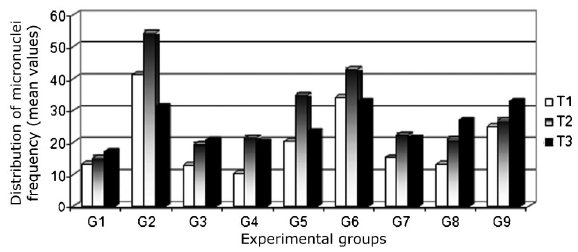
Figure 1. Distribution of the micronuclei frequency (means) in peripheral blood of mice during the 72 h of experimentation. G1: phosphate-buffered saline (PBS; negative control); G2: cyclophos- phamide (CPA; positive control); G3 to G6: 6-dimethylaminopurine (6-DMAP); G7 to G9: cycloheximide (CHX). T1, T2, and T3: collection of peripheral blood at 24, 48, and 72 h after treatment, respectively.